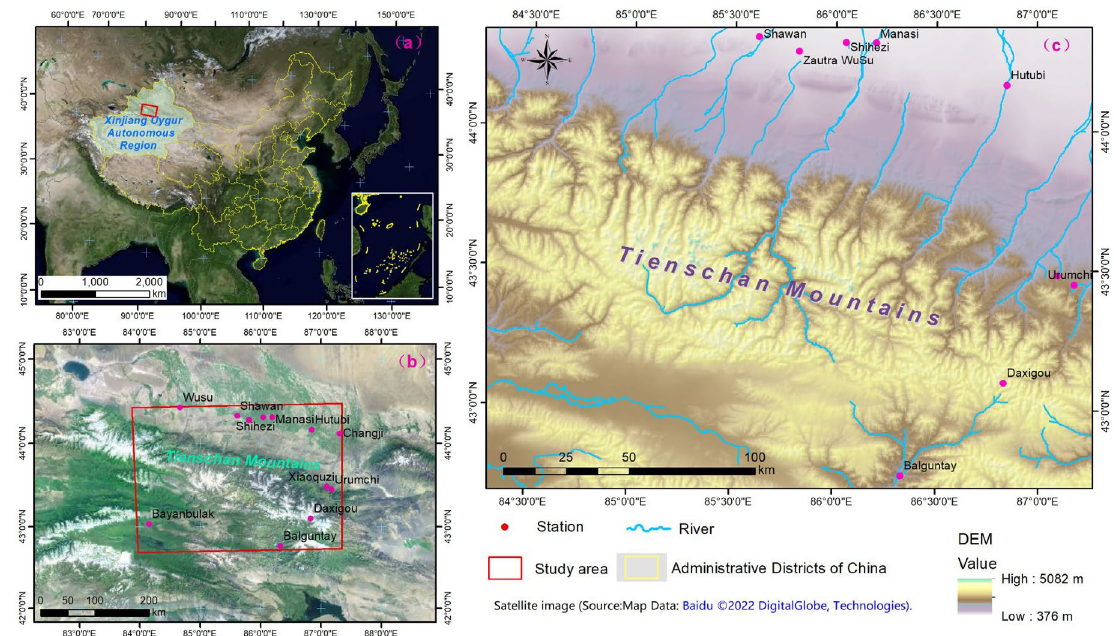
Figure 1. Location of the study area. ( a , b ) show the location of study area within China and Tianshen mountains with the satellite image obtained from Baidu ©2022 DigitalGlobe, Technologies (https:// map. baidu. sug= 0&l= 18&b= (13432 344. 21318 52,36516 17. 47214 46065; 13433 629. 44763 8426,36522 04. 28151 1593) & from= webma p& biz_ forwa rd=% 7B% 22sca ler% 22: 1,% 22sty les% 22:% 22sl% 22% 7D& device_ ratio=1). The red dots are the meteorological stations. ( c ) is the elevation map that obtained from Resource and Environment Science and Data Center (https:// www. resdc. cn/ Defau lt. aspx). Map created in ArcMap 10.6 of the Environmental System Resource Institute, Inc. (https:// www. esri. com/ softw are/ arcgis/ arcgis- for- deskt op). Boundaries made with free vector data provided by National Catalogue Service for Geographic Information (https:// www. webmap. cn/ commr es. do? method= dataD ownlo ad).